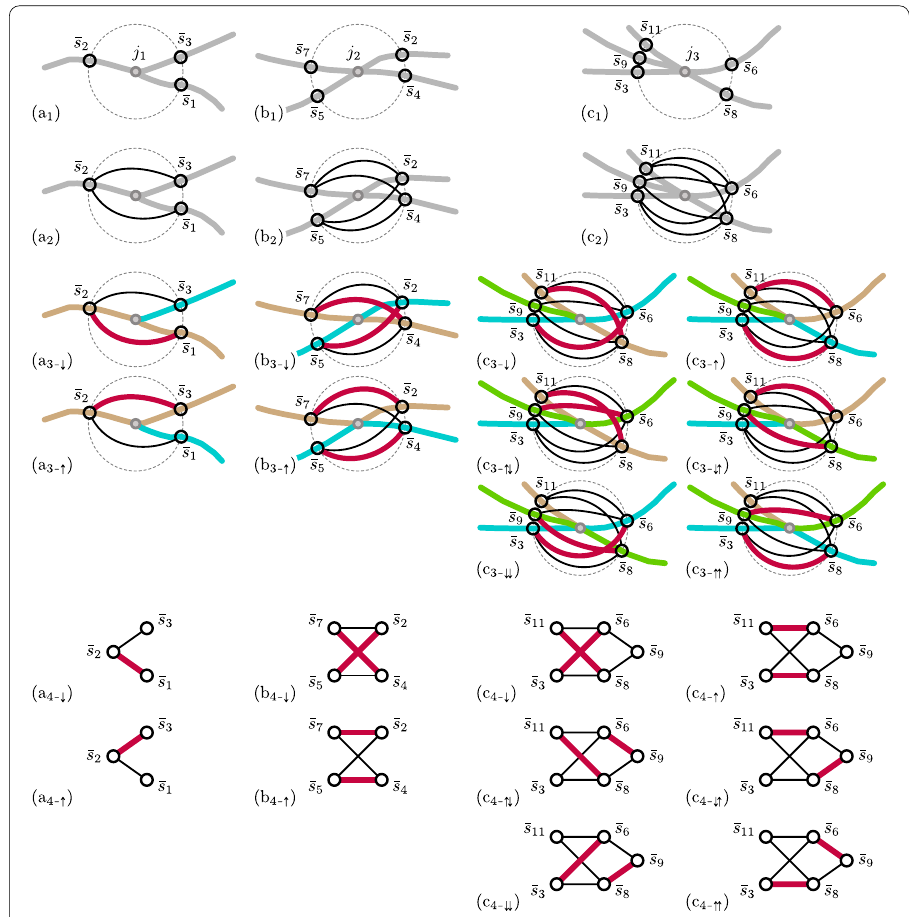
Fig. 4 Set of maximum matchings associable to a junction: the columns ( a ⋆ ), ( b ⋆ ), and ( c ⋆ ) outline why and how we can associate a set of maximum matchings to any junction through junctions j 1 , j 2 , and j 3 , respectively, from the notional example in Fig. 1. The subfigures actually organize themselves in a table: each column corresponds to a notional junction; each row corresponds to a step of our outline. First step : associate to each street-segment a node—we can place each node at the intersection of the street-segment with a circle centred at the junction so that each graph is a circular graph. Second step : link each node to any node along which it might continue its way (see Fig. 2)—each graph is actually a graph representation of the pairable street-segments. Third step : enumerate all the street layouts which could be achieved as part of a configuration of streets according to the state-of-the-art (see Fig. 3)—the construction of the street layouts follow the scheme used in Fig. 3, while the subgraphs link the so paired street-segment-nodes with a fat red edge. Fourth step : by representing the subgraphs in canonical form, we immediately realize that Step three actually enumerate all the subgraphs with the maximum number of non-adjacent edges, namely, all the maximum matchings—this completes our outline. Notice that the subfigure labels in rows 3 and 4 enumerate the maximum matchings with balanced ternary numbers using down-spin ( ↓ ), nil-spin (0), and up-spin ( ↑ ) as ternary digits (Knuth 1997). This enumeration offers between maximum matchings of junctions joining three or four street-segments and Ising spin states (down ↓ and up ↑ ) a close analogy as junctions j 1 and j 2 exemplify well here. This analogy appears to hold as well for our less typical junction j 3 . Figure 5 uses a simpler but more visual enumeration based on the regular polygons—extended with the degenerate regular digon. Each corner (side) represents then a maximum